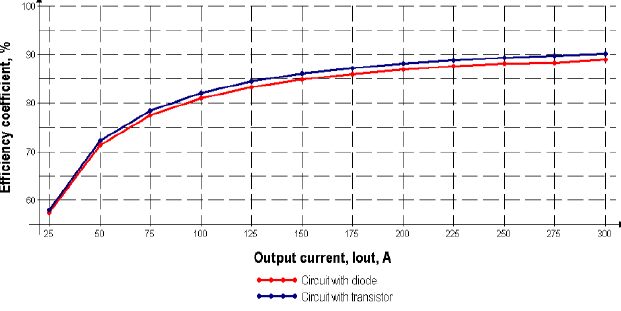
Fig. 12. The dependence of the efficiency of both circuits on the